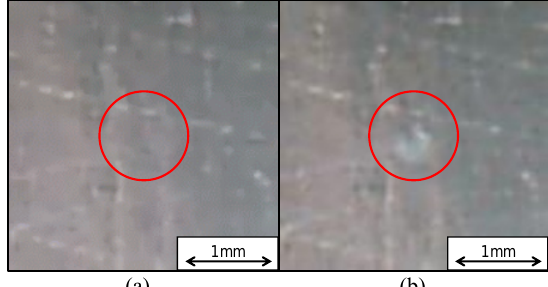
Fig. 4. Micrograph of epoxy resin surface before (a) and after (b) the delamination was detected.